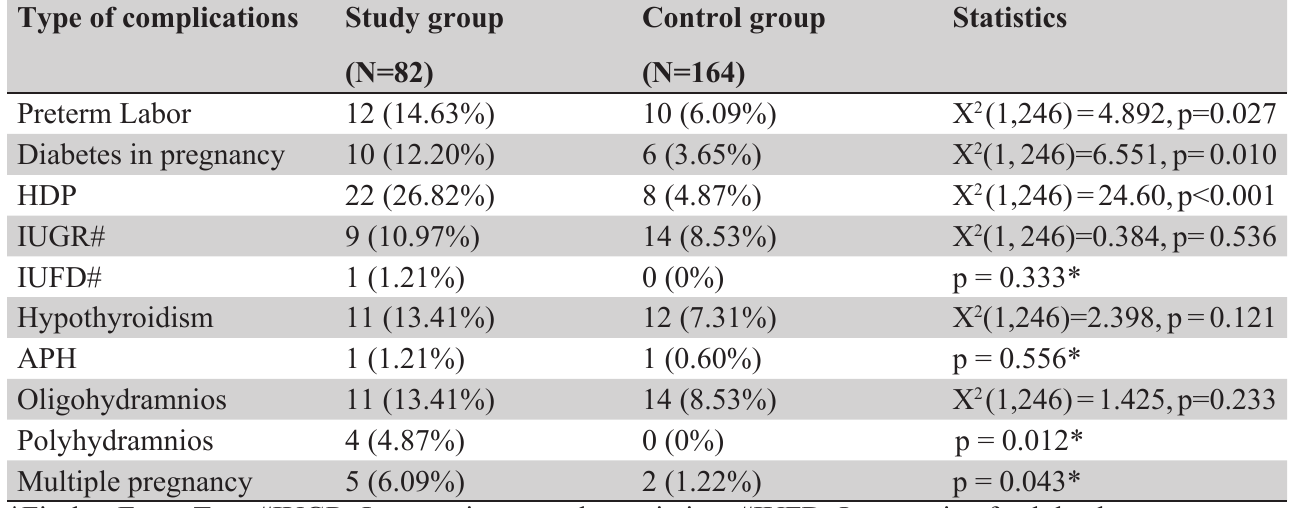
Table 1. Comparison of complications in the antenatal